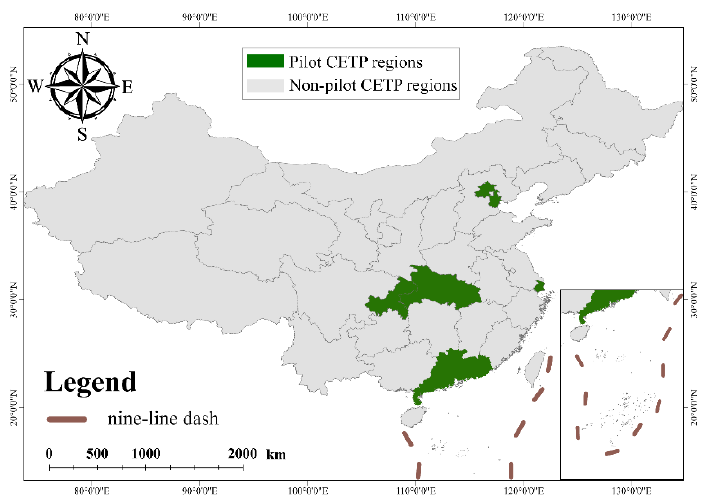
Figure 2. Spatial distribution of pilot regions for China’s emission trading policy.